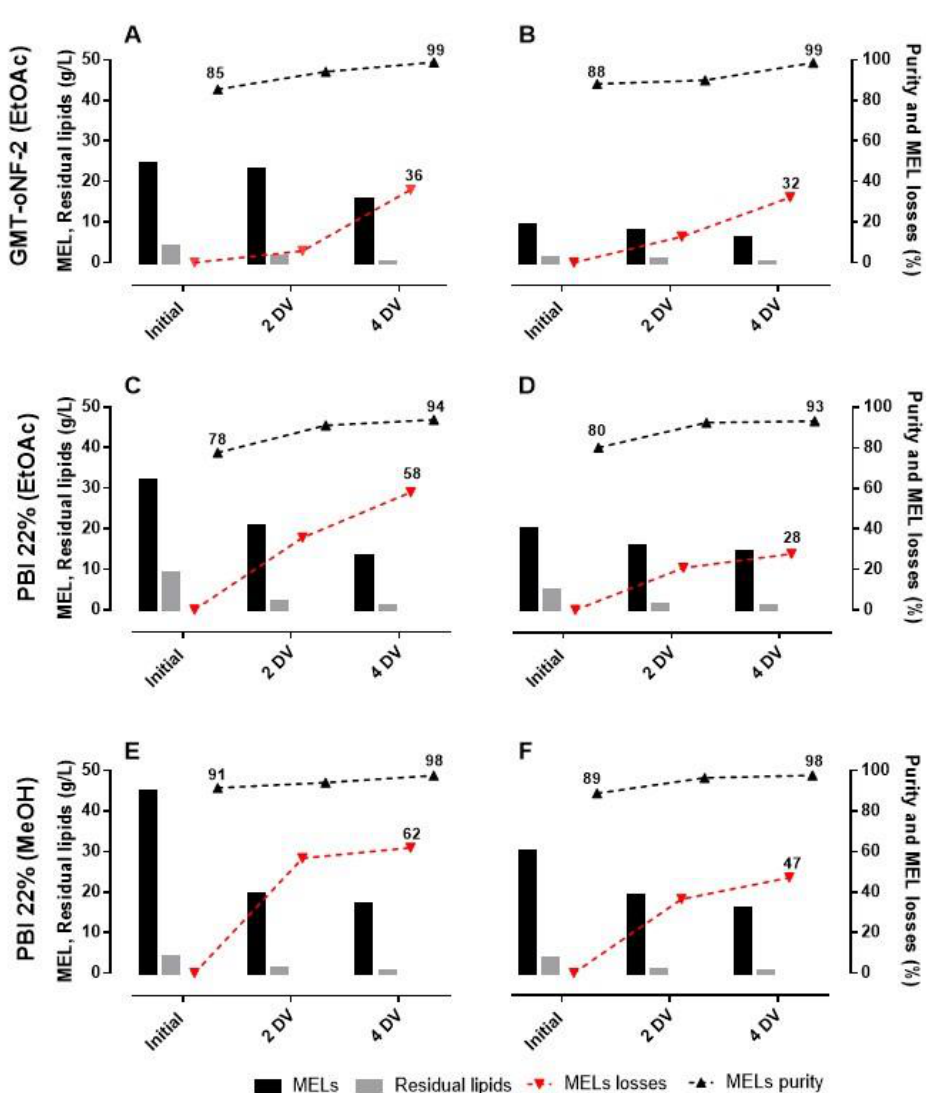
Figure 6. Cascade system using OSN membranes: GMT-oNF-2 ( C – F ) and PBI 22% using EtOAc ( A – D ) and MeOH ( E , F ) as organic solvents. After the first filtration ( A , C , F ) the permeate was concentrated and passed again through the same membrane ( B , D , E ). Each graphic represents the concentration of MELs in the retentate (black bar), residual lipids (grey bar), MELs losses (red line with inverted triangles) and purity (black line with triangles). For all filtrations used, the volume was kept at 50 mL, and 15 bar of pressure was applied.